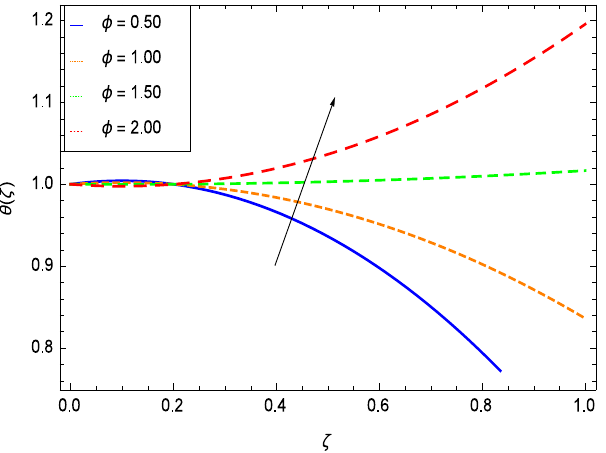
Figure 13. Conduction layer at h = − 1.80, β = 0.10, n = 1.50, We = 0.50, S = 0.50, M = 2.00, Nr = 1.00, Pr = 10.00, A 3 = A 4 = 0.20, A = π with the enhancement in φ 4